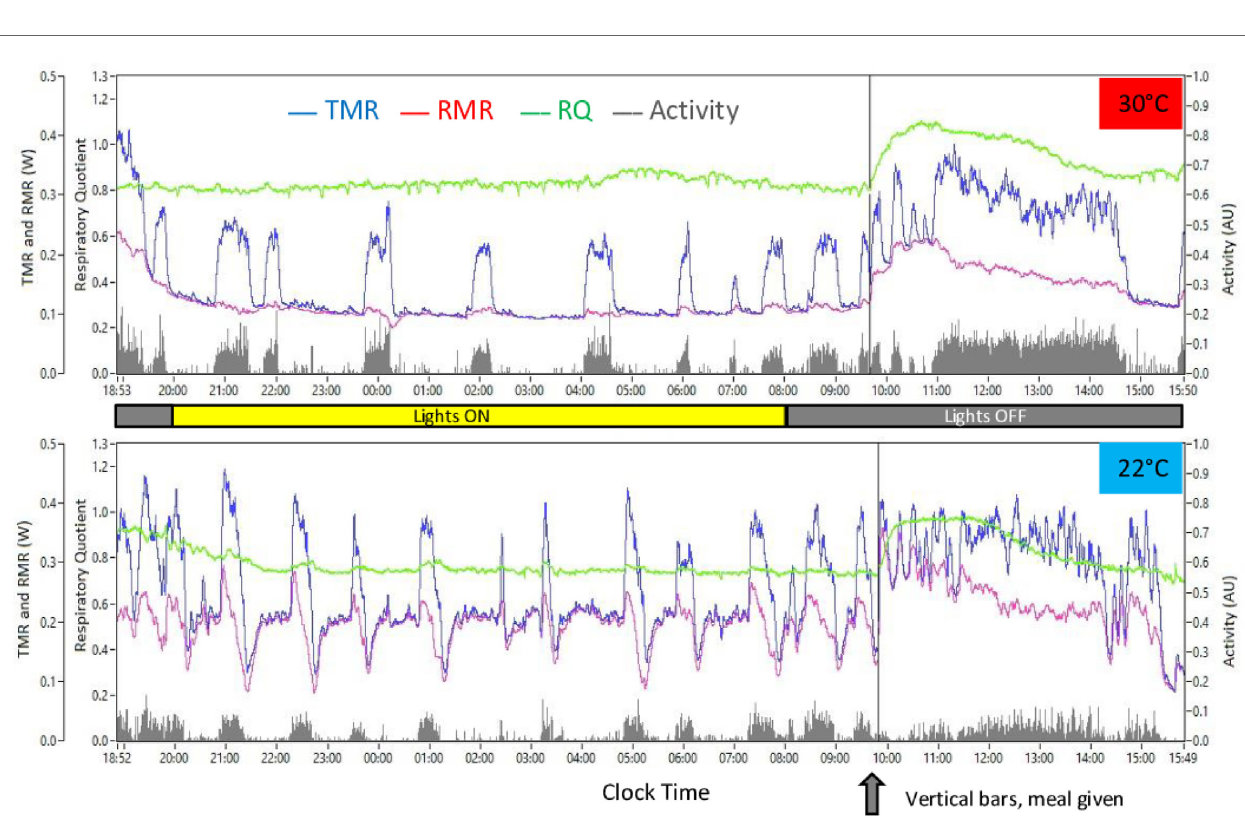
FigUre 3 | example of results observed in response to ingestion of a meal-test after overnight (mainly during the light period for the mouse) food restriction (screen copies of the computer program developed in the laboratory to edit the calorimetry data) . Top, mouse housed at 30°C (2014 study); bottom, mouse housed at 22°C (2016 study). VO 2 , VCO 2 , and activity data were initially recorded at 2 s intervals then processed by the method of Kalman to compute TMR and RMR. RQ was computed as VCO 2 /VO 2 . Vertical bars crossing the figures indicate time when the meal was introduced into the cage.